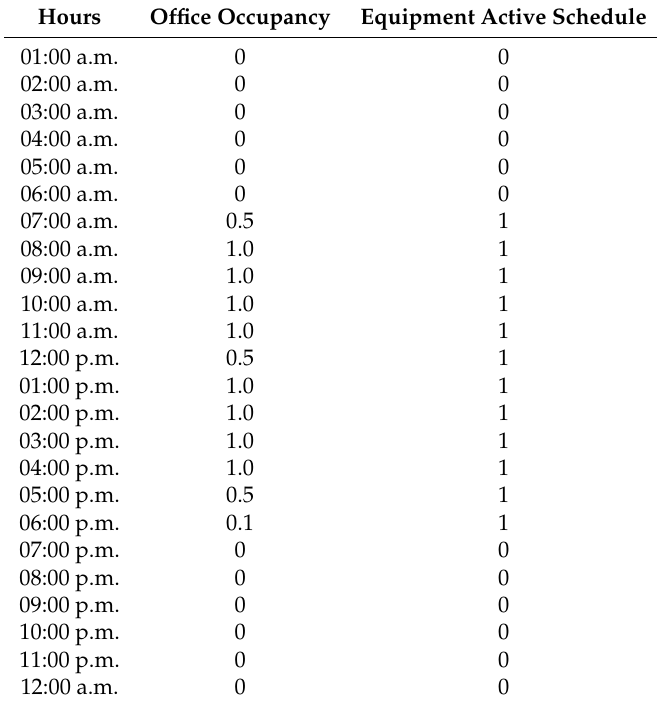
Table 1. This table provides the daily occupancy schedule for a typical work day on an hourly-basis. Values reported in fractions. This occupancy schedule was used in our simulation.